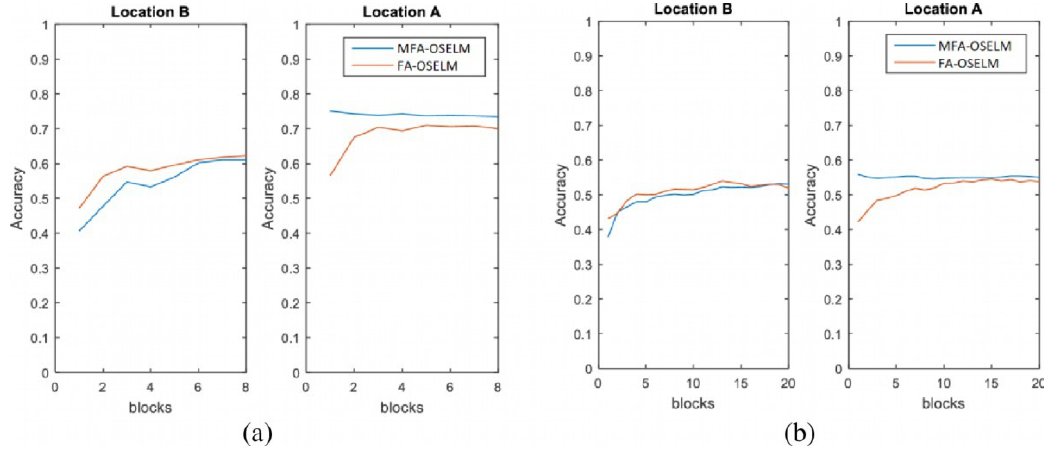
Figure 6. Scenario 2: the accuracy of MFA-OSELM and FA-OSELM for ( a ) the TampereU dataset and ( b ) the UJIIndoorLoc dataset.